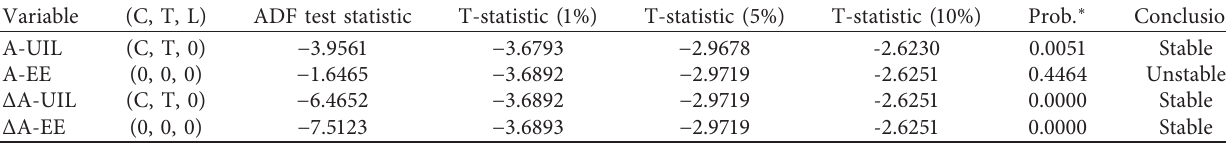
Table 7: ADF test results of the urban innovation level and eco-efficiency.